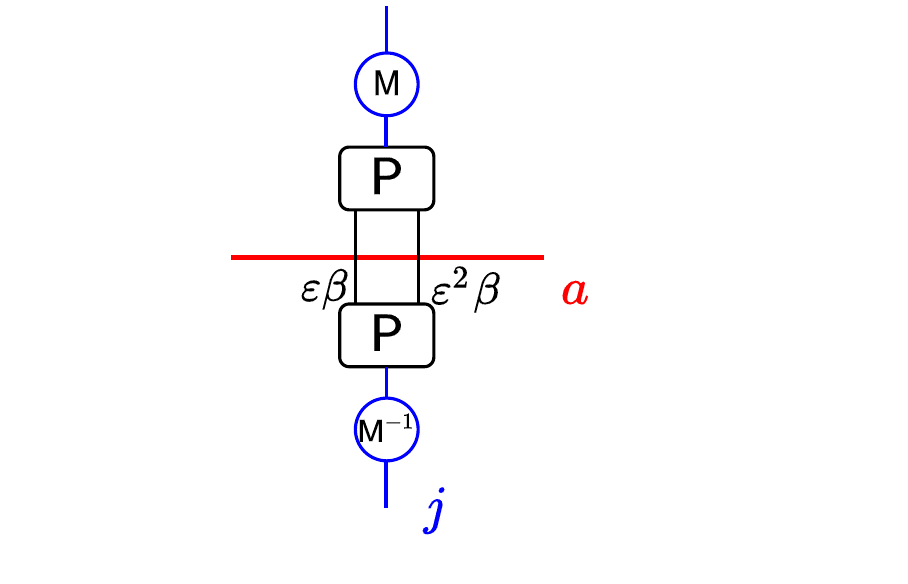
Figure 2: The semi-cyclic Lax operator of ZF model is expressed as a fusion of two Lax operators of spin-1 / 2 XXZ model, cf. (70). Blue lines correspond to physical Hilbert space with spin-1 representation of su algebra, which are obtained through 2 the fusion of two spin-1 / 2 representations denoted as black